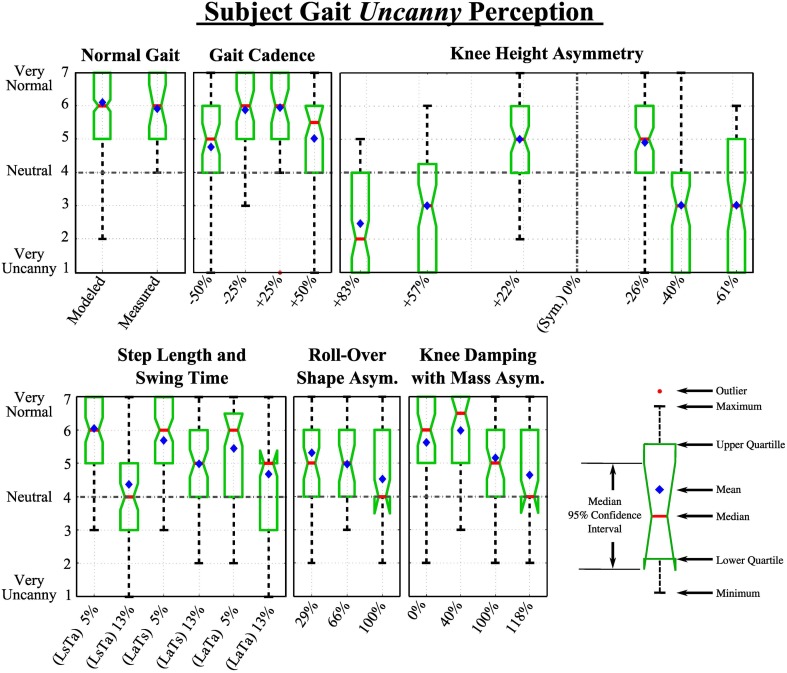
Extended box and whiskers notch plots show participant's responses to videos in each category in response to the question: “How eerie or uncanny does this gait appear?”.